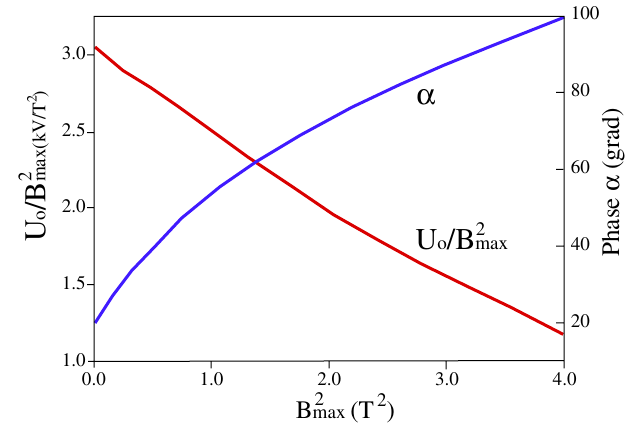
=B max2 and (cid:1) as a function of B max2 FIG. 12. (Color) U 0